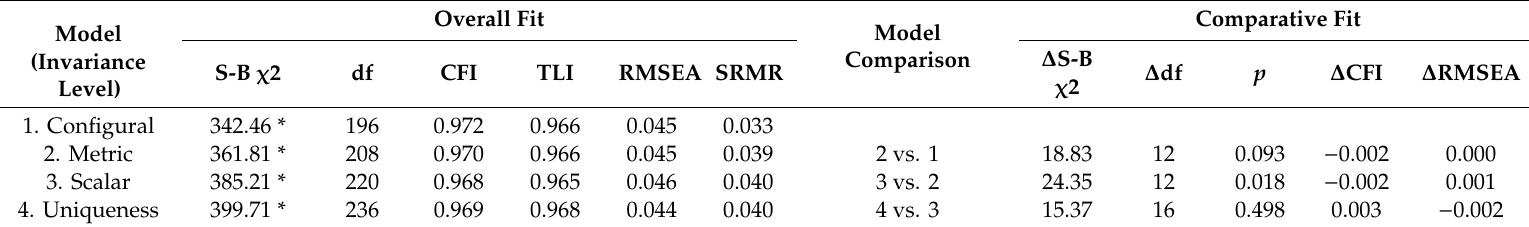
Table 3. Measurement invariance tests of the SBPN4 four-factor model across gender.